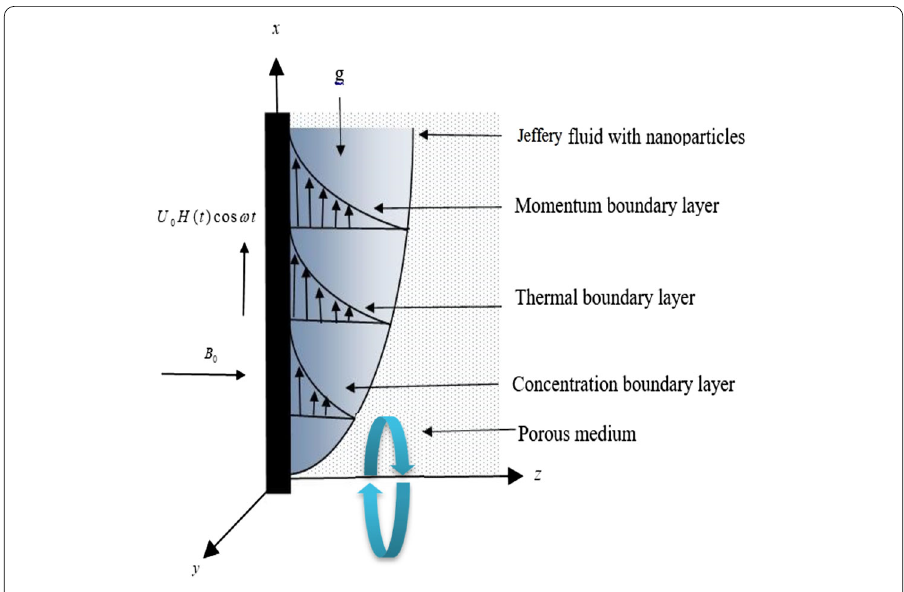
Figure 1 Geometry of the